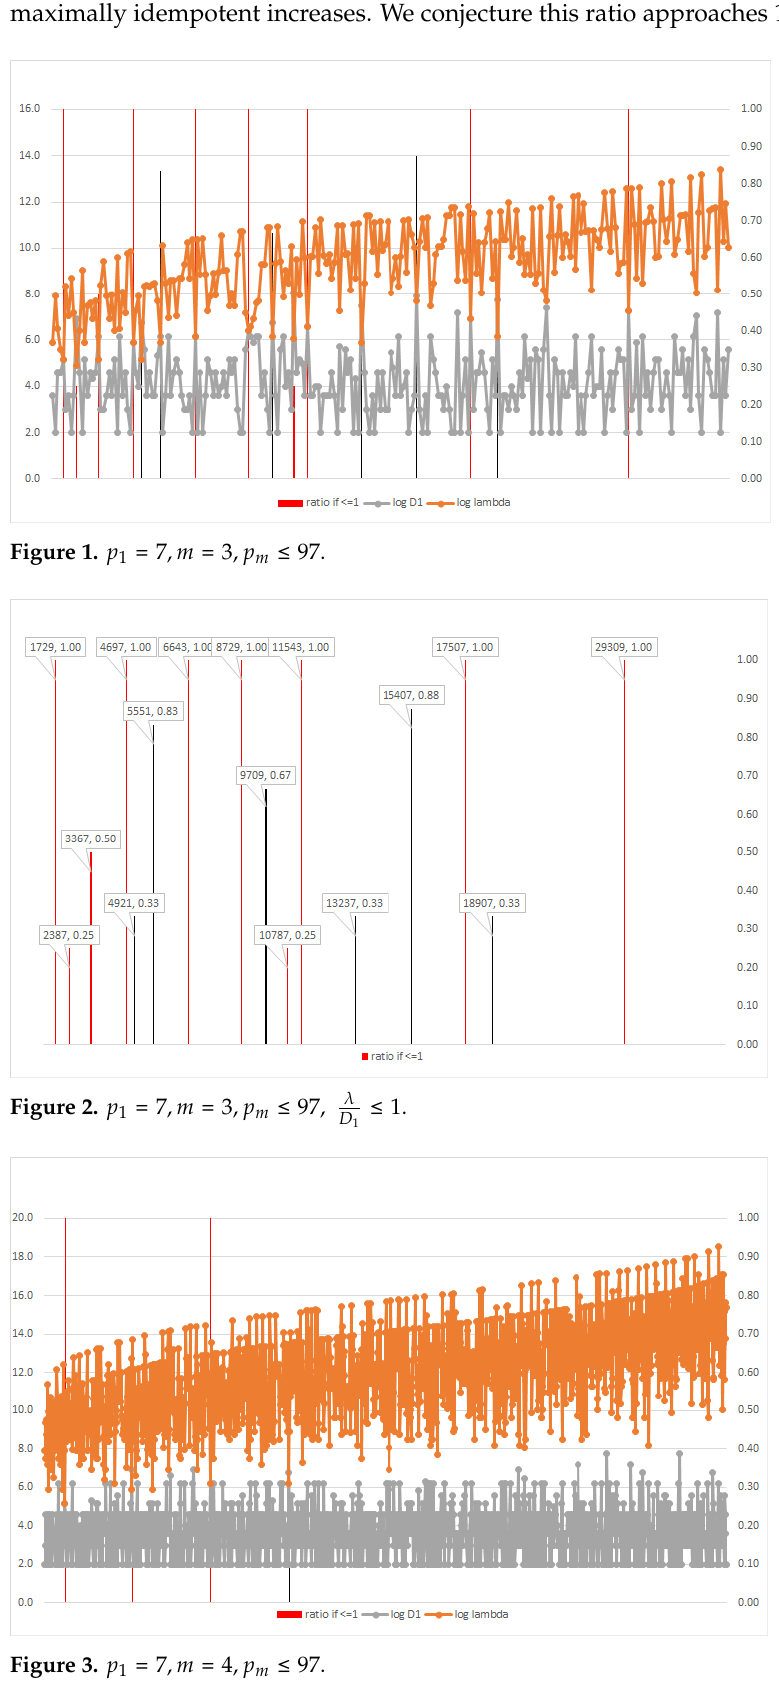
Figure 3. p 1 = 7, m = 4, p m ≤